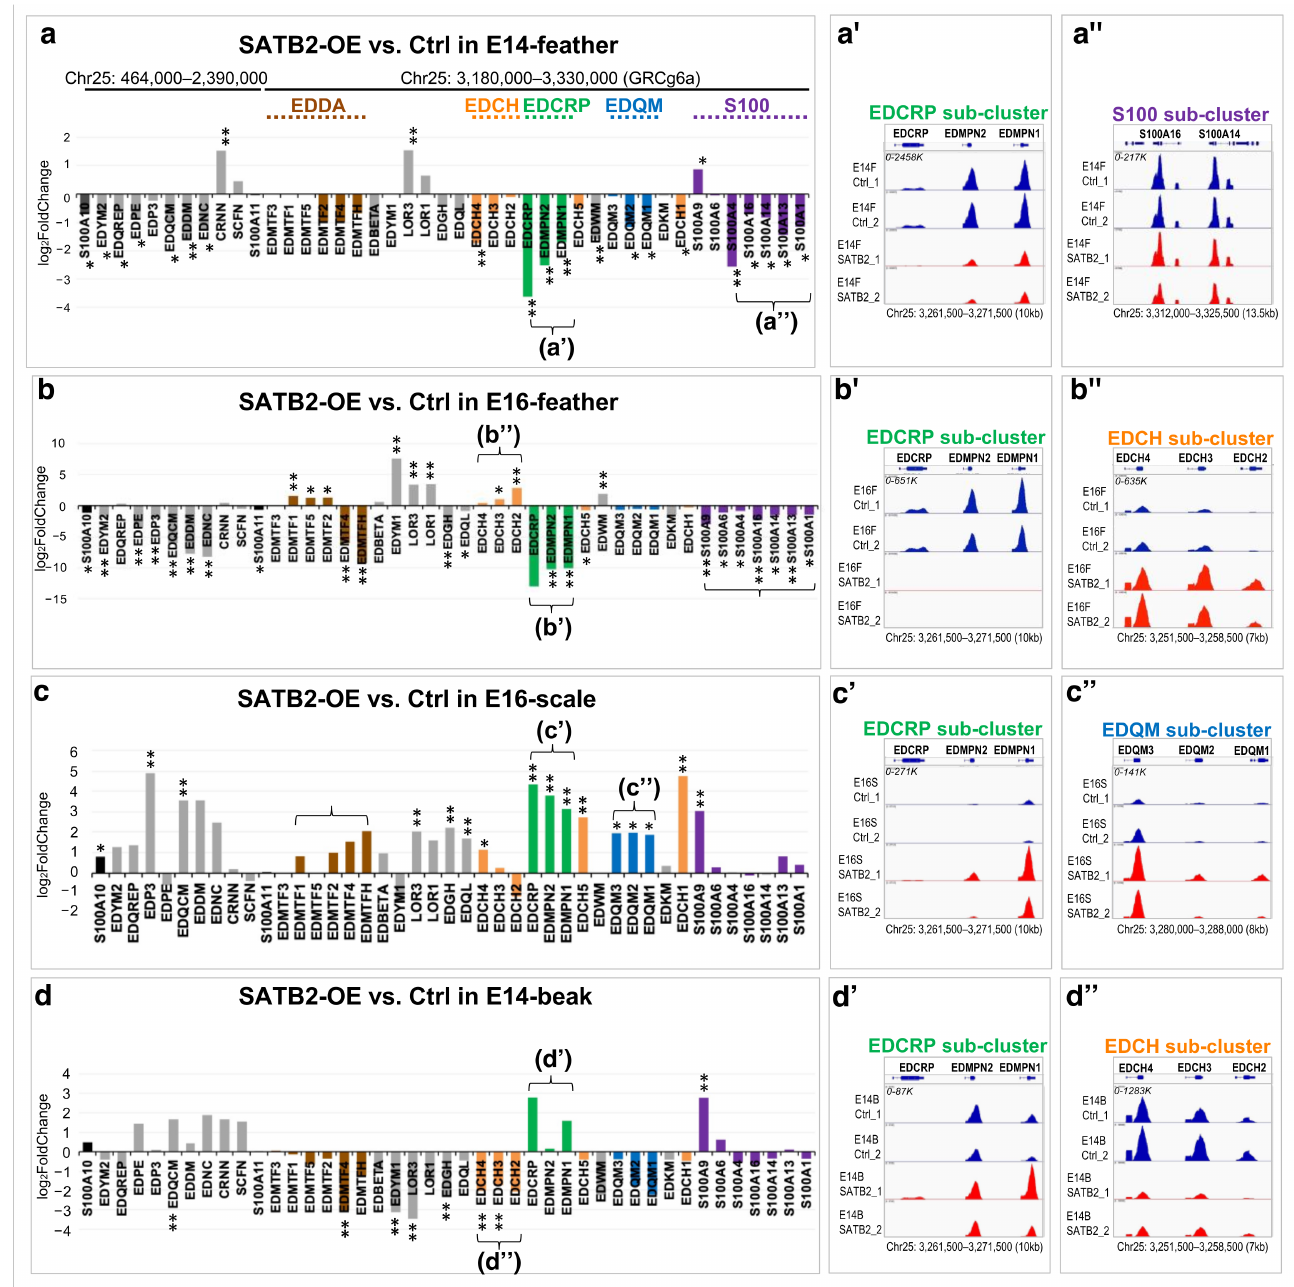
Figure 3. The related expression level of non- β -EDC on Chr25 when SATB2 proteins are overexpressed in different skin appendages. ( a – a” ) Feathers at E14; ( b – b” ) Feathers at E16; ( c – c” ) Scales at E16; ( d – d” ) Beaks at E14. The fold changes and statistical significance of DEG indicated in ( a – d ) are collected from Supplementary Tables S2–S5. DEG with an FDR < 0.05 are indicated by asterisks (*) and DEG with a Log2 fold change over 1.5 or less than − 1.5, under the excess of SATB2, is marked by double asterisks (**). Five sub-clusters of EDC members (EDDA, EDCH, EDCRP, EDQM, and S100) are indicated by different colors, the same as those in Figure